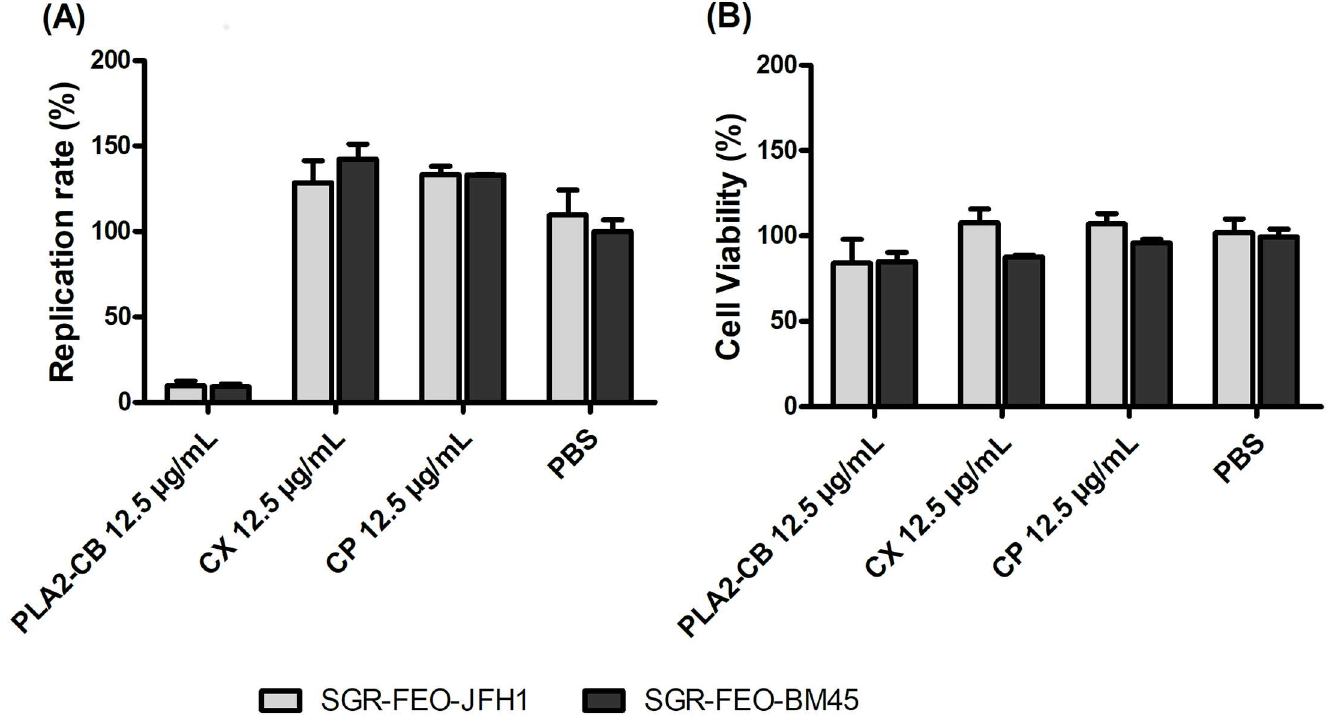
Fig 3. Effect of toxins on genotype 1b. Huh-7.5cells were electroporated with 2 μ g of RNA SGR-Feo-BM-45 genotype1b and seeded into 96-wellplate. After 24 h, cells were treated with PLA 2 -CB, CX or CP at 12.5 μ g/mL and maintained for 48 h. HCV replication was quantifiedby measuring luminescence levels (A) and cell viabilityabsorbance(B). P < 0.001 was consideredsignificant( *